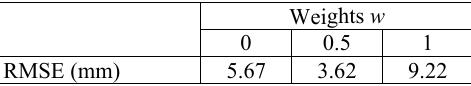
Table 2. RMSE (mm) of the